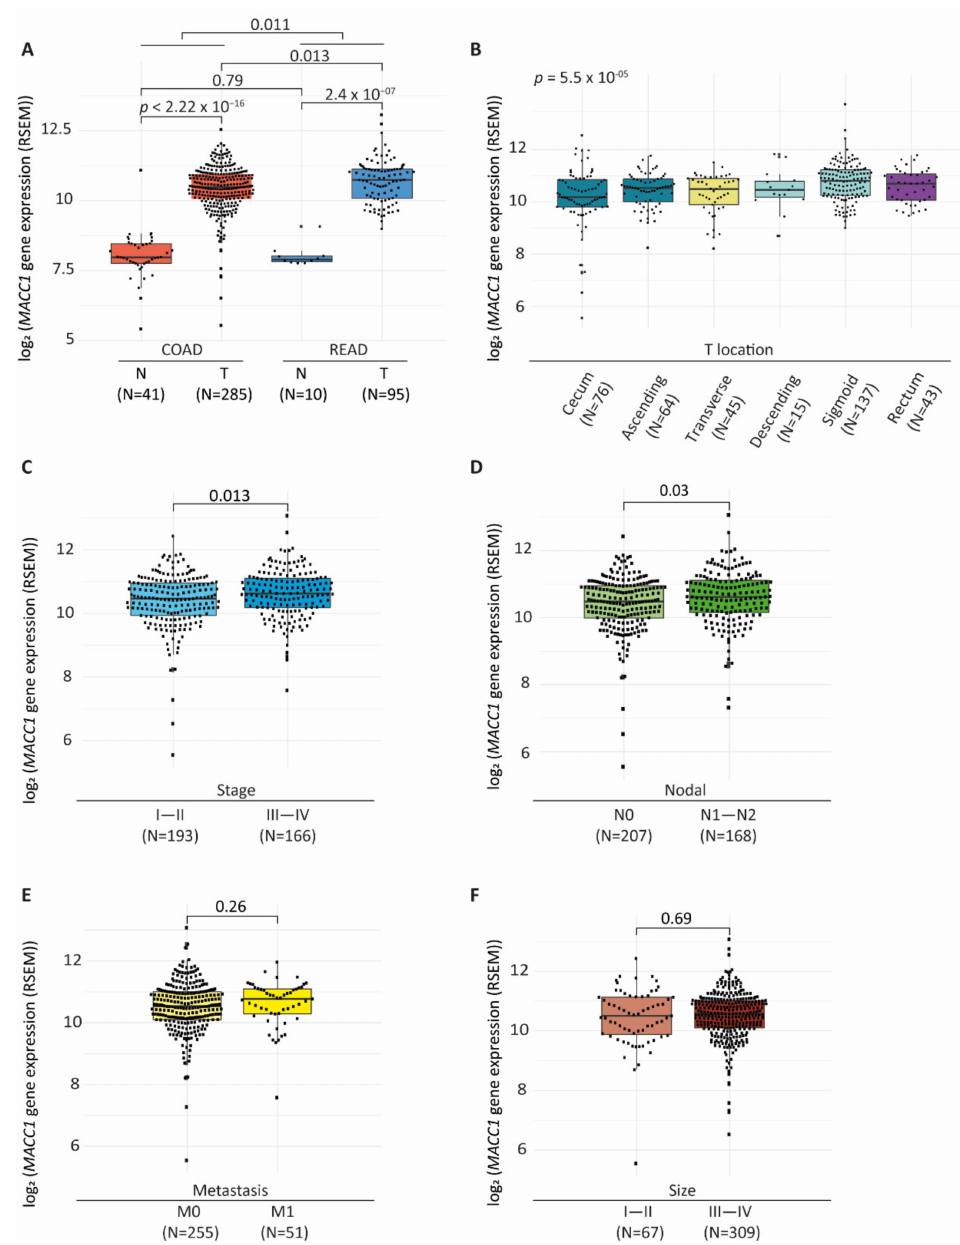
Figure 2. MACC1 expression in the COAD-READ dataset. ( A ), Box plot showing MACC1 mRNA expression values of the COAD and READ samples stratified by normal or tumor tissue types. ( B – F ), MACC1 mRNA expression by tumor ( B ), localization, ( C ), stage, ( D ), patient nodal invasion, ( E ), patient metastatic status, ( F ), size. Box plots ( A – F ), MACC1 data are RNA-Seq data RSEM-log2 transformed, horizontal bars indicate median values, boxes are interquartile range, whiskers indicate values within 1.5 times interquartile range. The number of samples (N) per group is given in